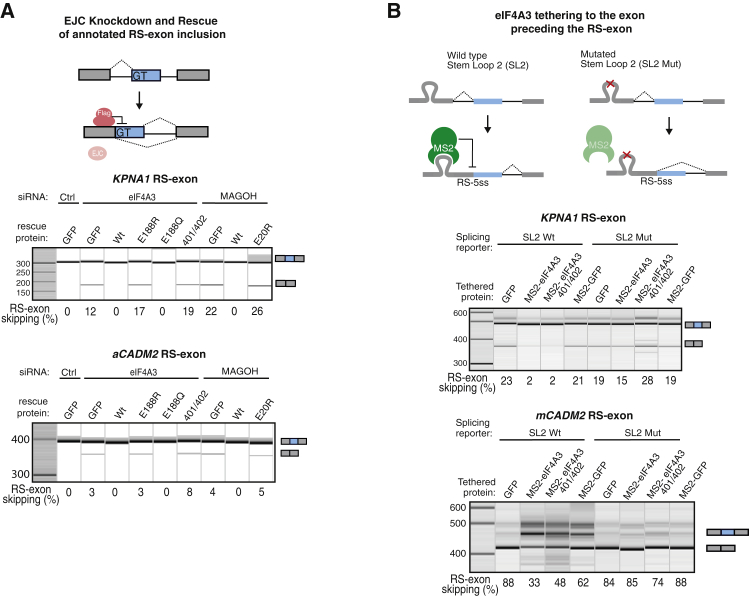
Stable EJC Deposition Is Required to Block Recursive Splicing(A) KD of EJC components was rescued with siRNA-resistant FLAG-tagged counterparts. The splicing pattern of endogenous KPNA1 or stably integrated aCADM2 RS-exons was monitored by RT-PCR.(B) Wild-type or mutant SL2 sequence was inserted into KPNA1 and mCADM2 splicing reporters at the expected EJC deposition site, and the splicing pattern was monitored by RT-PCR after co-transfection of SL2 reporters and plasmids expressing the indicated MS2-tagged proteins.A minimum of 3 independent replicates was performed in HeLa (A) or 293 (B) cells.